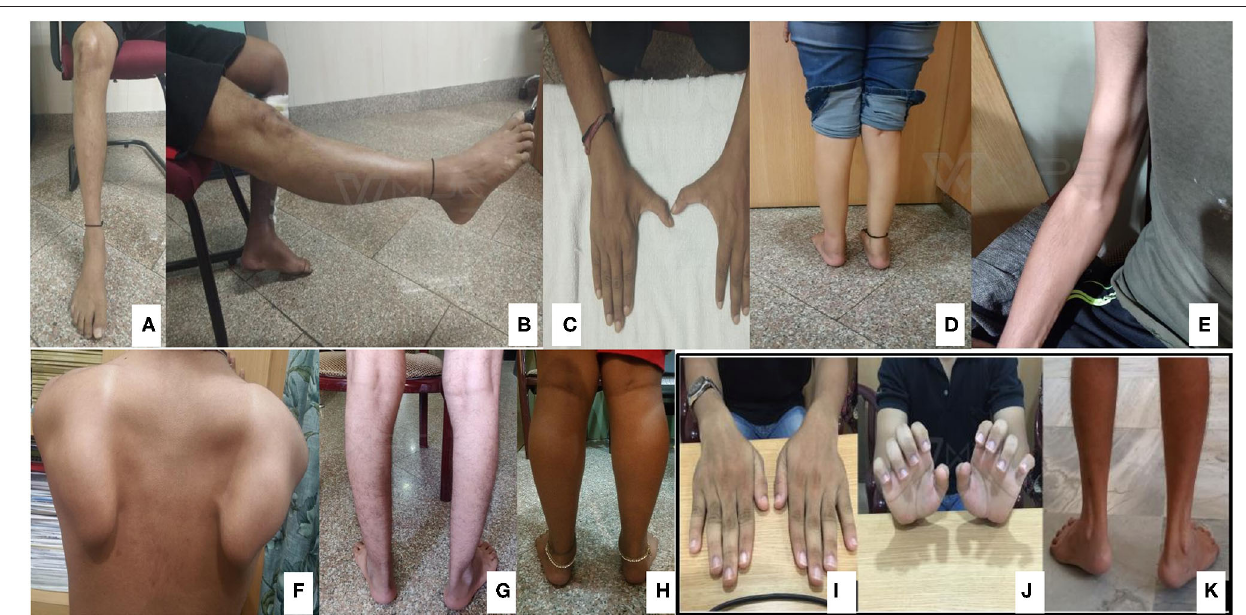
FIGURE 3 | Classical features of common subtypes identified. GNE myopathy (A–C) : Tibialis anterior (TA) muscle wasting, normal quadriceps, and first dorsal interossei (FDI) muscle wasting identified, respectively. Dysferlinopathy (D,E) : Gastrocnemius wasting and biceps lump. Calpainopathy (F,G) : Scapular winging and ankle contracture. Sarcoglycanopathy (H) : Calf hypertrophy. Collagenopathy (I–K) : Long finger flexor and ankle contractures.